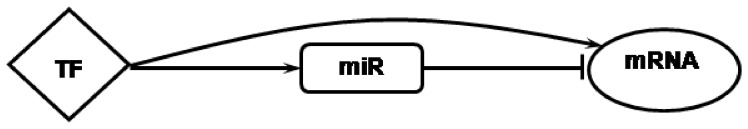
Regulatory relationship between TF, miR and mRNA.TFs and miRs often function in a coupled way. TFs can regulate the transcription of both the miR and its target mRNA by binding to their respective promoter region, while miRs regulate gene's post-transcription by binding to the 3′ untranslated region (UTR) of target mRNA.